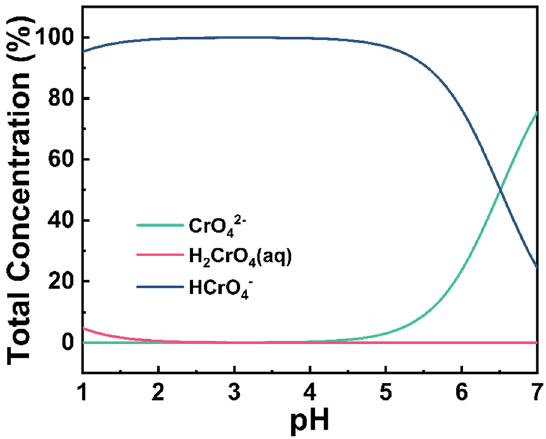
Figure 7: The existing forms of Cr ( VI ) in aqueous solutions under di ff erent pH.